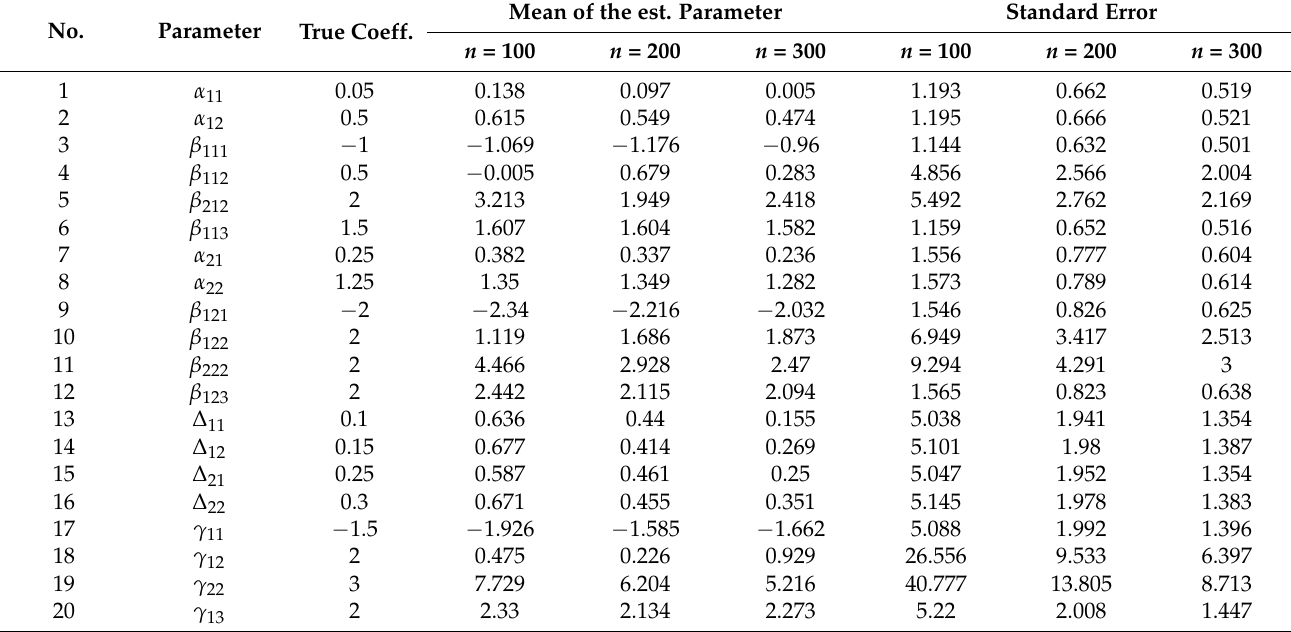
Table 2. Mean of the estimated parameter and the corresponding standard errors of the BPOLR model for different sample sizes.